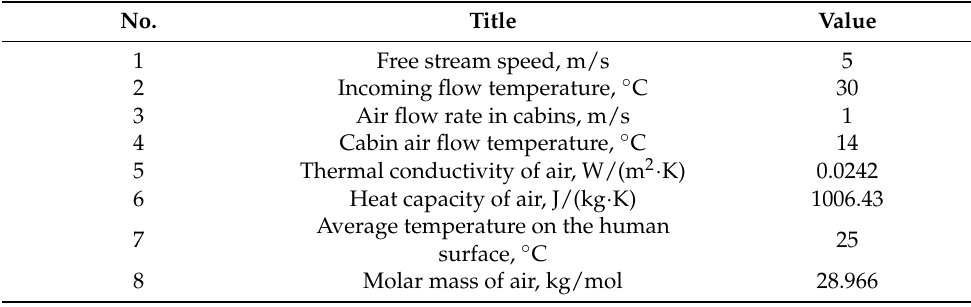
Table 2. Boundary conditions and environment parameters.